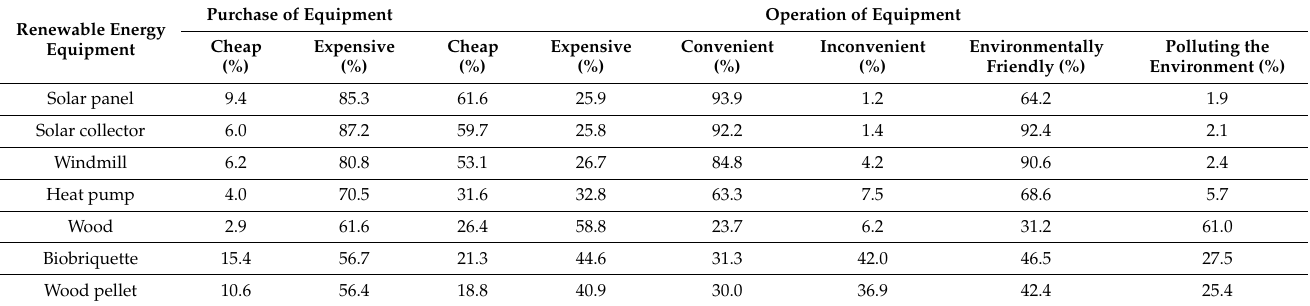
Table 7. Assessment of energy sources based on the purchase and operation of the energy equipment ( N = 1002). Purchase of Renewable Energy Equipment